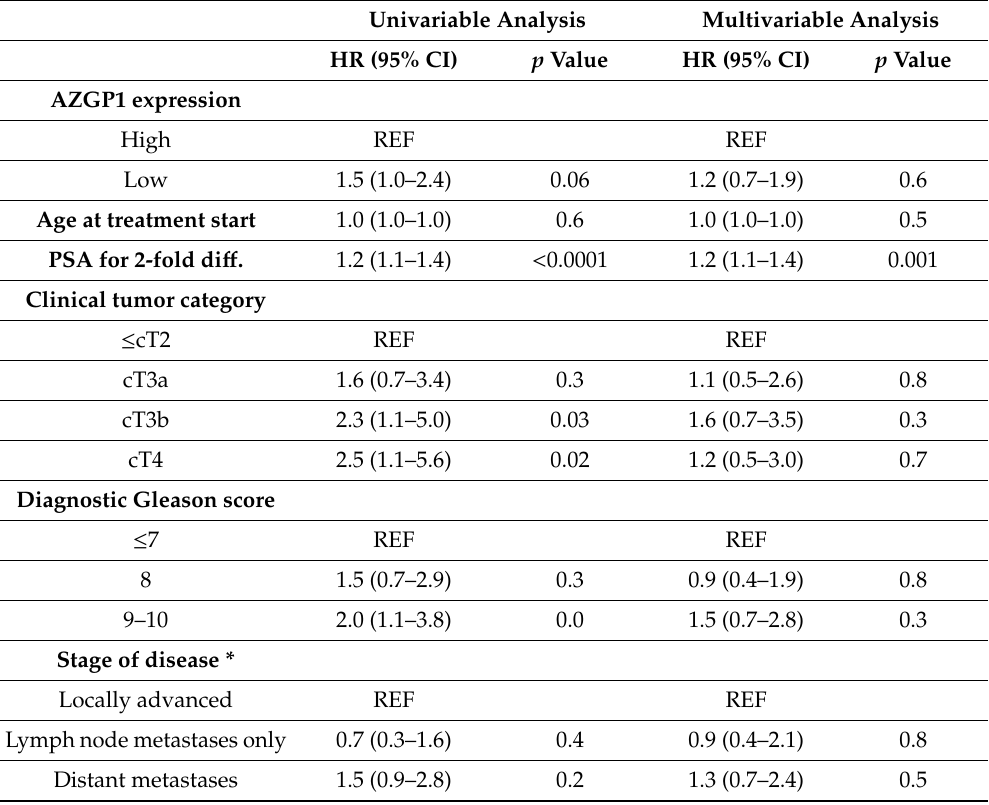
Uni- and multivariable cause-specific Cox proportional hazards of the risk of PCa-specific